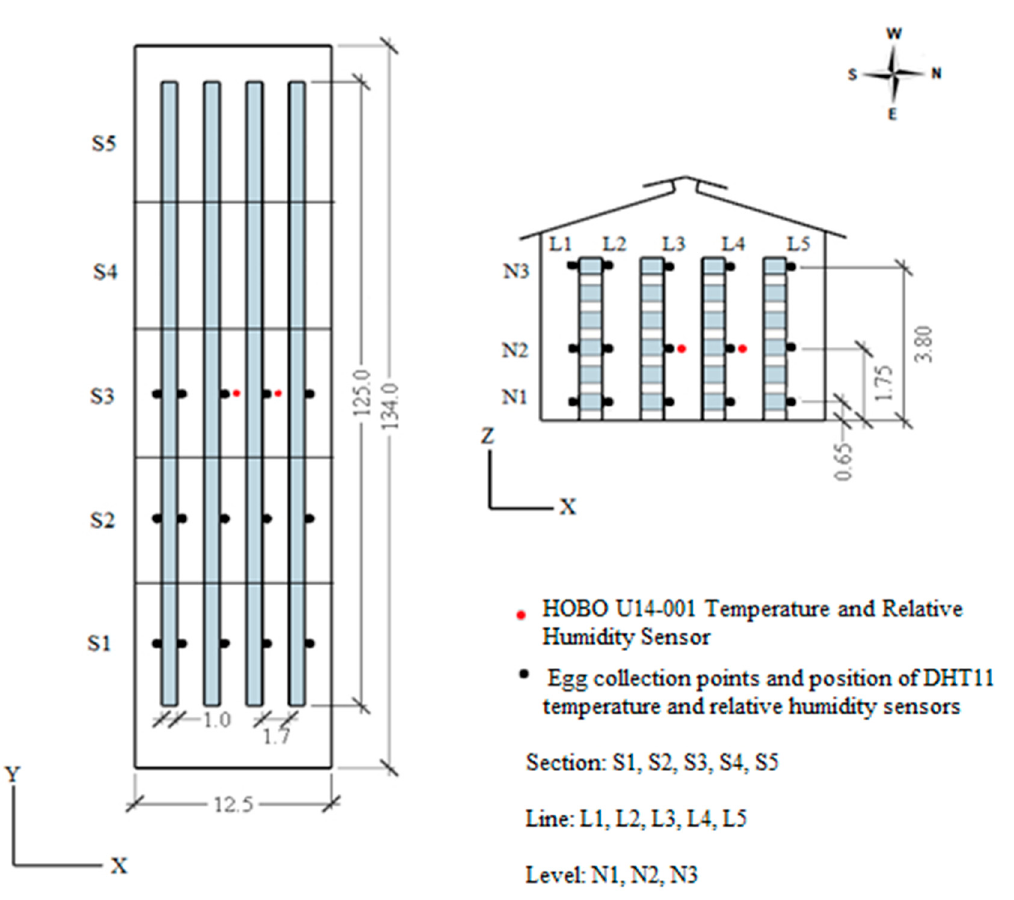
Figure 2. Spatial location of egg collection points and temperature (°C) and relative air humidity (%) sensors. Dimensions in meters.